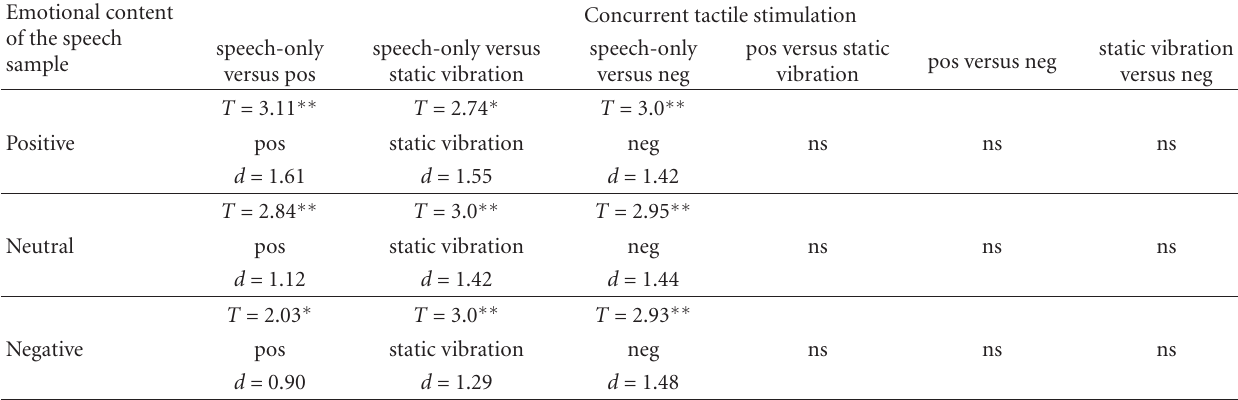
Table 7: Pairwise comparisons between the concurrent tactile stimulation categories within each of the speech samples used. Emotional